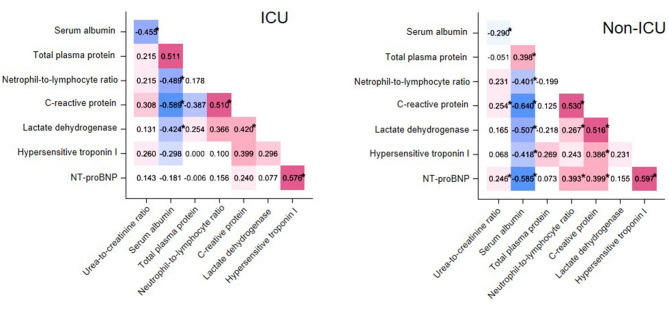
Matrix heatmap representing correlations between laboratory test values in cases (ICU patients, left) and controls (non-ICU patients, right). Correlations with Spearman's rho < 0 and rho > 0 are colored blue and red, respectively, while the saturation of the color reflects the magnitude of r. *P < 0.05.